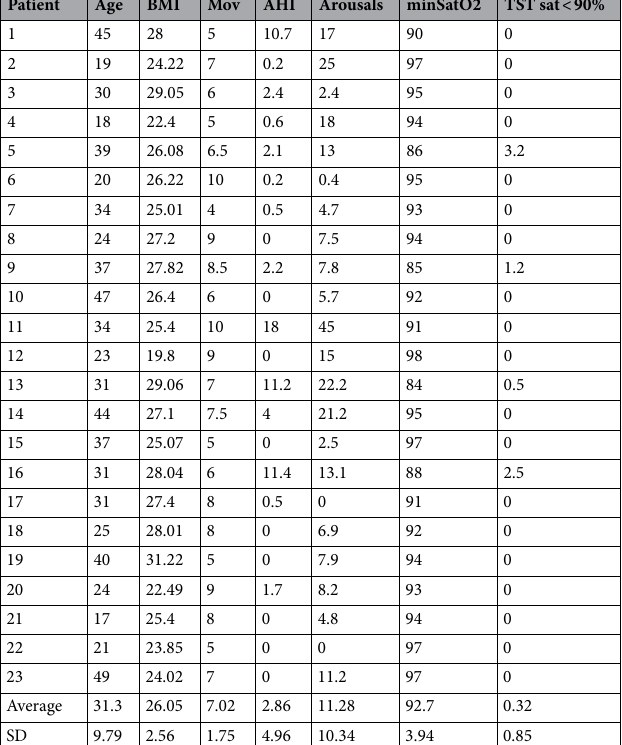
Table 2. Characteristics of the patients in the MA group. Age: years; BMI: kg/m 2 ; Mov. Millimeters; AHI: